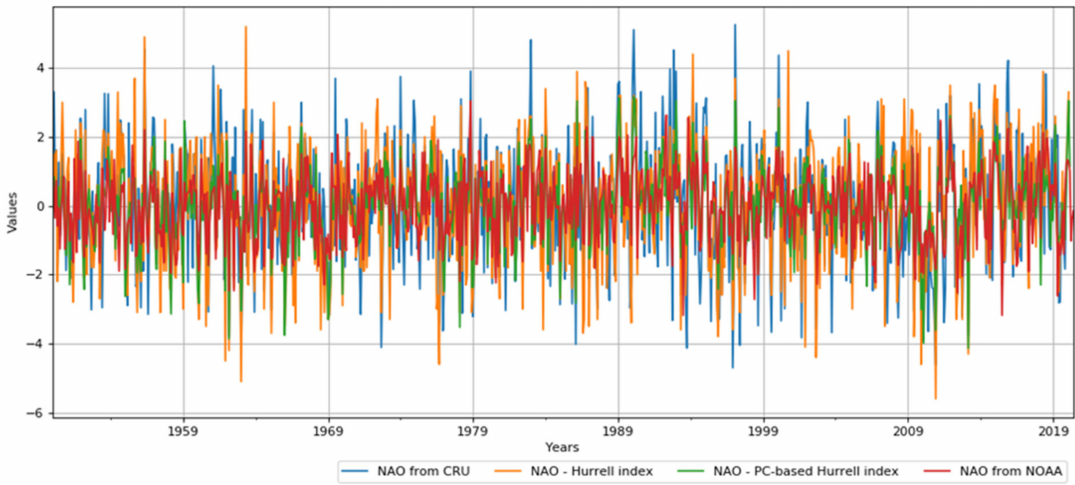
Figure 12. Time series of NAO indices (NAO from CRU, NAO Hurrell index, NAO PC-based Hurrell index, and NAO from NOAA) in 1950–2019.